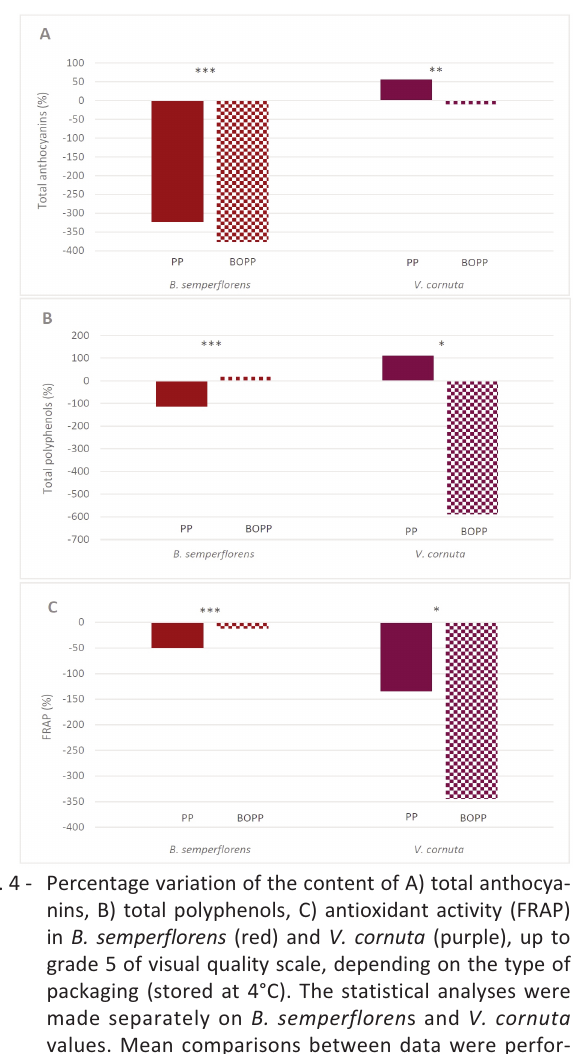
*Fig. 4 ­ Percentage variation of the content of A) total anthocya­ nins, B) total polyphenols, C) antioxidant activity (FRAP) in B. semperflorens (red) and V. cornuta (purple), up to grade 5 of visual quality scale, depending on the type of packaging (stored at 4°C). The statistical analyses were made separately on B. semperfloren s and V. cornuta values. Mean comparisons between data were perfor­ med using an independent samples T­test. * p≤0.05. ** rence. PP= plastic box + lid; BOPP= Plastic box without its lid, inserted into a bi­oriented polypropylene plastic